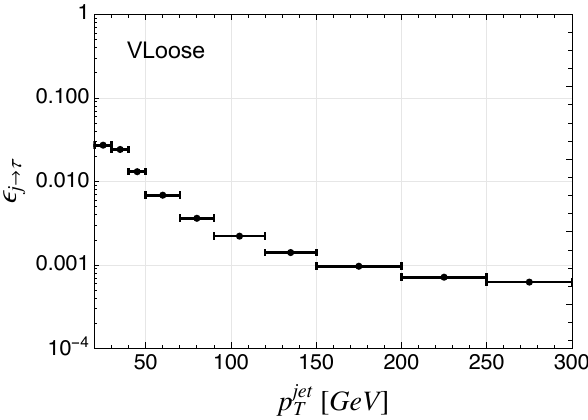
Figure 1 . The misidentification rate of j → τ for the VLoose working point taken from the CMS performance of reconstruction and identification of tau leptons using data at